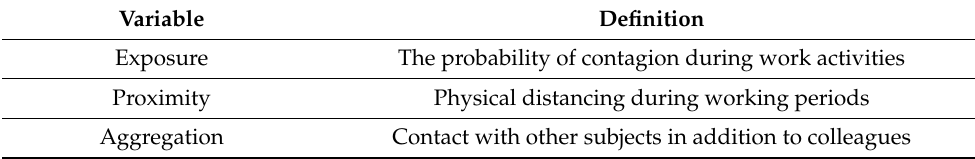
Table 1. Critical variable to consider for SARS-CoV-2 risk